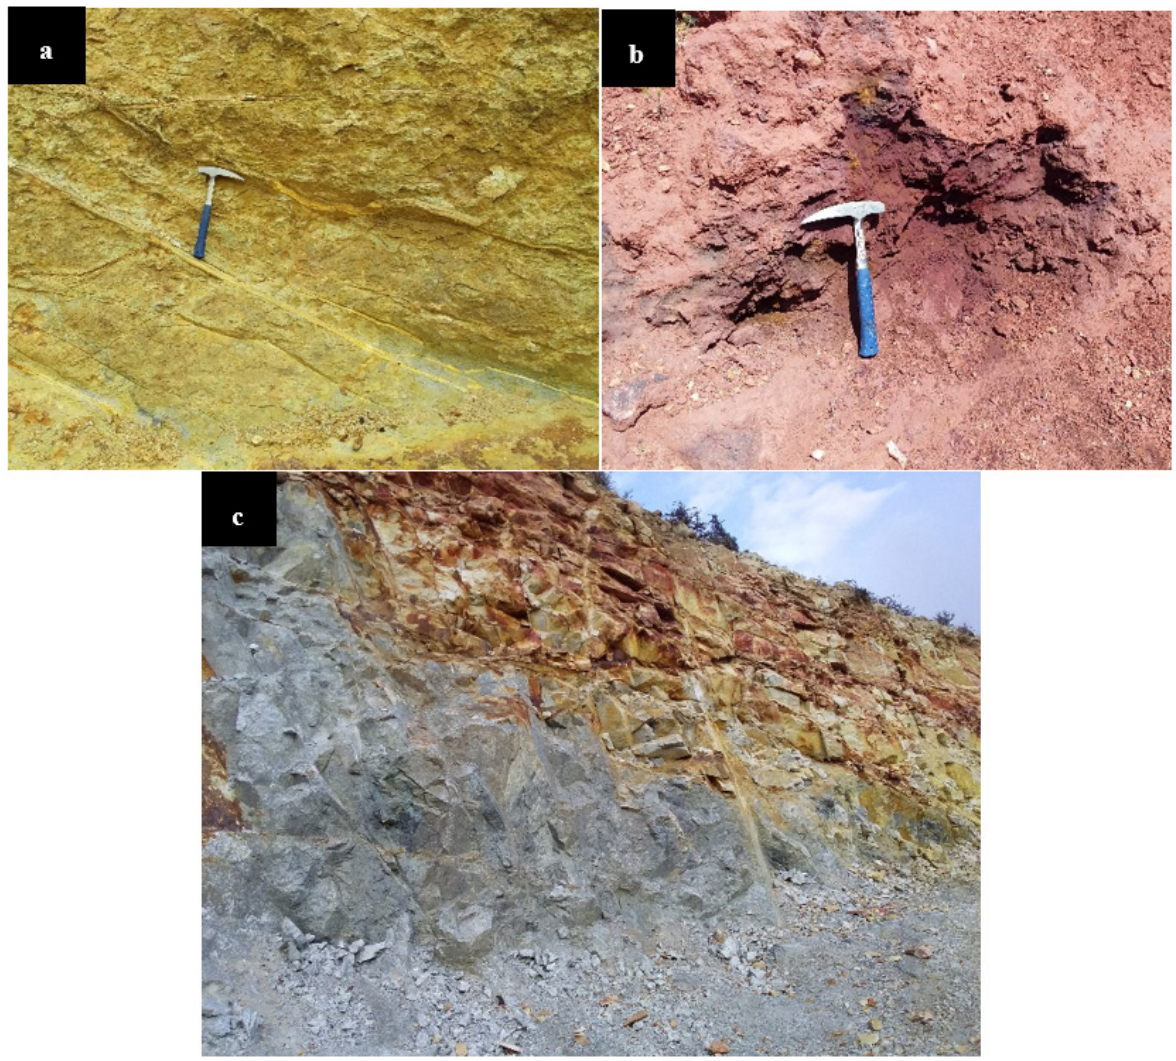
Figure 8. Field photographs of control points. ( a ) argillic alteration, ( b ) iron oxide alteration ( c ) Phyllic alteration.